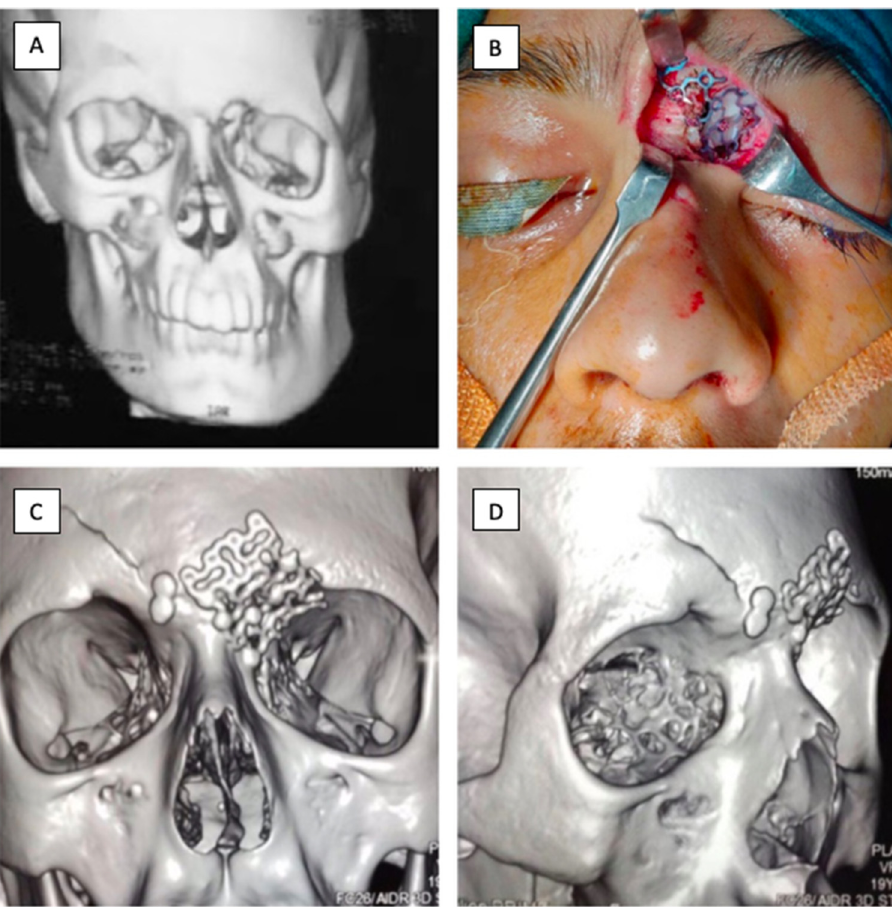
Fig. 5. Preoperative 3D reformatted CT scan showing the left medial orbital rim and roof fracture (A) which was reconstructed with a continuous titanium mesh. (B) Postoperative 3D reformatted image showing the adapted titanium mesh spanning the medial orbital roof